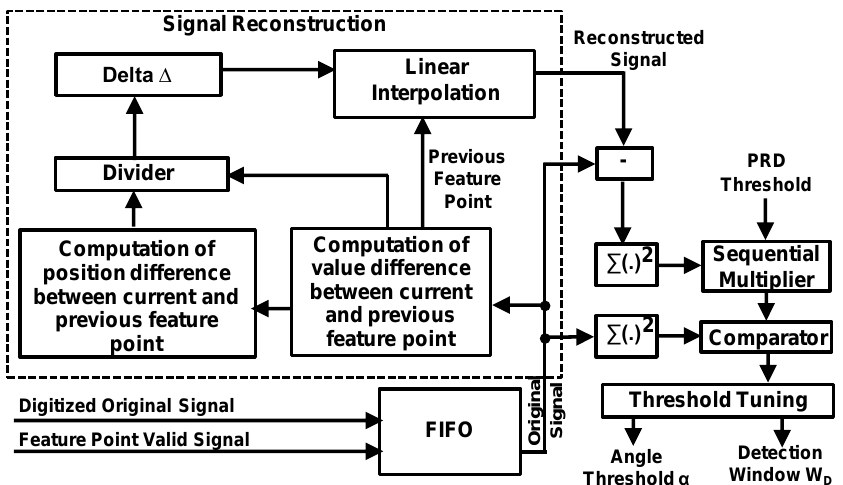
Figure 5. Adaptive threshold tuning module.